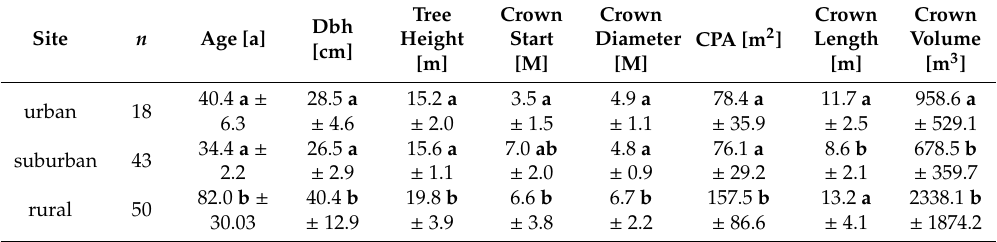
Table 4. Tree structures (age, dbh, tree height, crown start, crown diameter, crown projection area cpa, crown length and crown volume) of A. sachalinensis of measured urban, suburban and rural trees with tested di ff erences between categories. Di ff erent letters indicate significant di ff erences found by one-way Kruskal–Wallis test and following a post-hoc test; n = number of sampled trees.